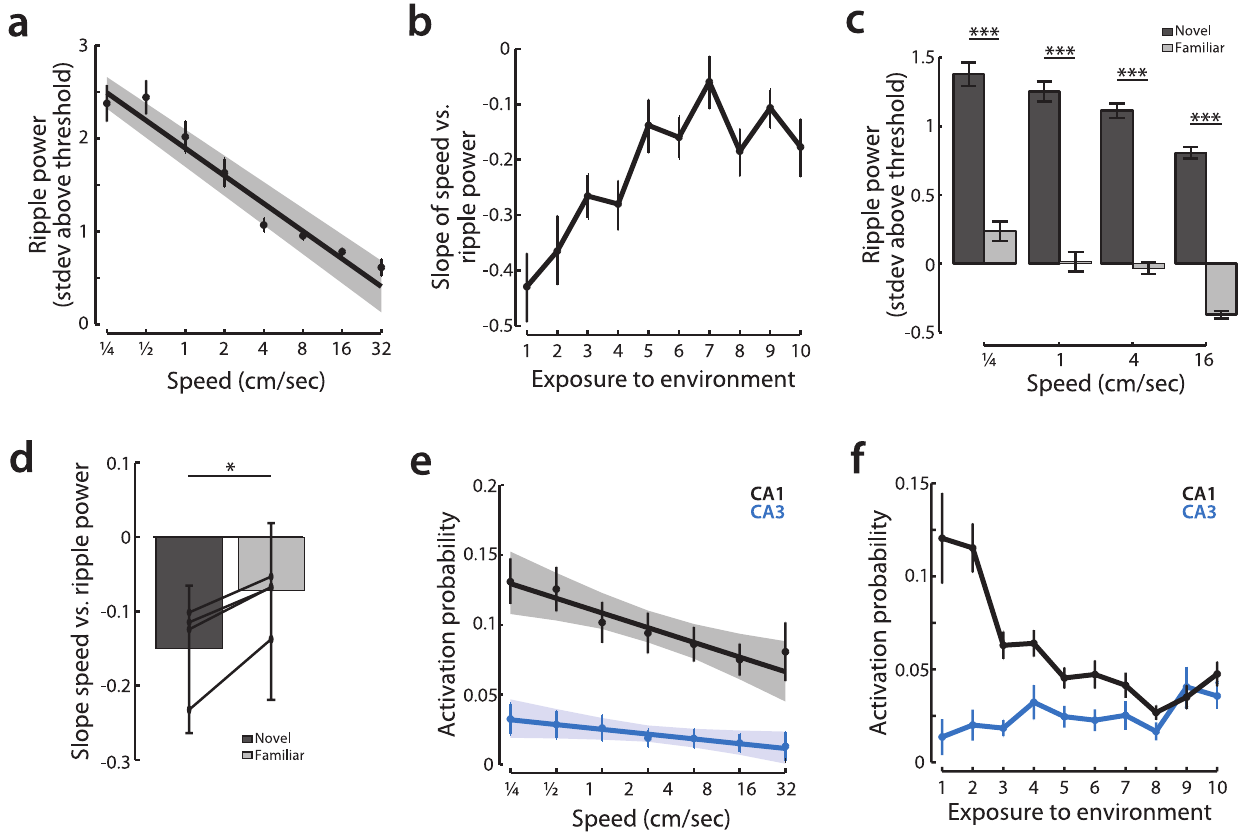
Figure 6. Ripple oscillations and CA1 spiking during ripples reflects the dynamics of CA3 input to CA1. a, Normalized ripple power (measured from threshold for detecting ripples) vs. speed. For clarity, normalized ripple power is displayed both as binned averages (binned means and standard error using logarithmically spaced bin centers) and regression to the underlying data (slope with 95% confidence range by bootstrap). b, Changes in speed modulation over exposures to the environment. Points represent means + / 2 95% confidence bounds by bootstrap. c, On days in which a second novel environment was experienced immediately following the first, more familiar environment (n=4; see methods), the effect of novelty on ripple power could be directly measured. Shown are the mean binned ripple power in the novel (dark gray) and familiar (light gray) environments. Ripple power is significantly increased in the novel as compared to the familiar environment for all speeds (rank sum test between novel and familiar session, p , 10 2 5 for all speed bins). d, The depth of ripple power modulation by speed is larger in a novel as compared to a familiar environment. For all animals where it was possible to measure within day changes, we find that there was a significant increase in the depth of modulation (more negative slope) in the novel as compared to more familiar environment. Bars show grouped data, means with 95% confidence intervals, thin lines show change in slope for individual animals (bootstrap estimate of slope, novel slope vs. familiar slope, p , 0.05 for group, p , 0.05 for individual animals). *p , 0.05; ***p , 10 2 5 . e, Activation probability during each ripple for CA1 and CA3 cells during the first exposure to the environment. For clarity, activation probability is displayed both as binned averages (binned mean and standard error using logarithmically spaced speed bins) and best fit line (linear regression of the underlying data with 95% confidence intervals). f, Mean activation probability for CA1 and CA3 neurons across exposures to the environment. Points show mean probability with 95% confidence bounds by bootstrap.